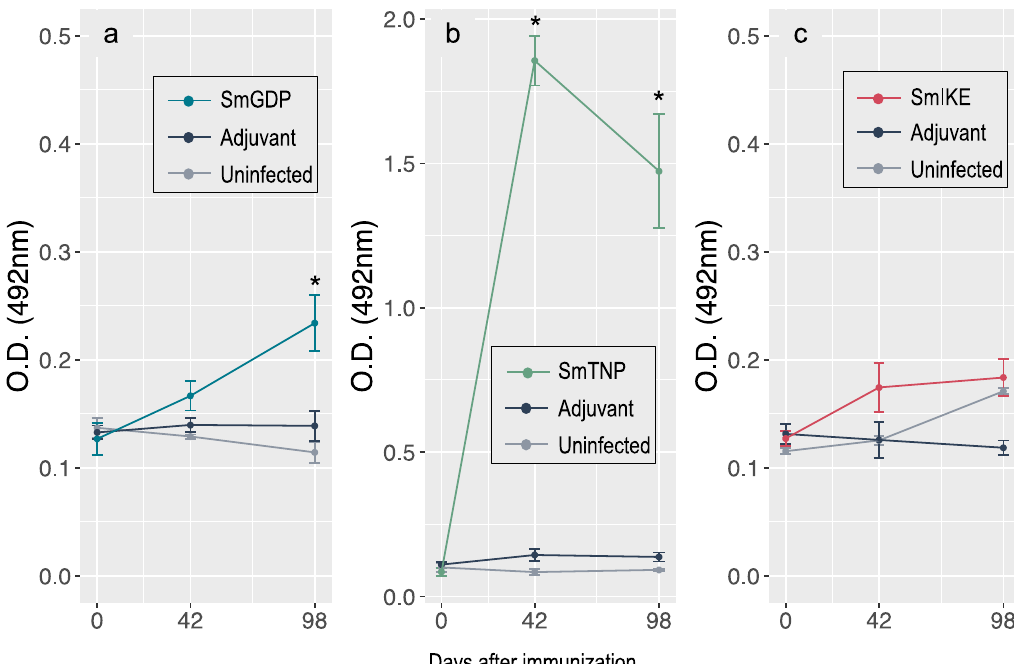
Figure 2. Specific IgG levels (means ± SEM) by indirect ELISA elicited by ( a ) SmGSP peptide, ( b ) SmTNP peptide and ( c ) SmIKE peptide formulated in the adjuvant adaptation (ADAD) vaccination system, with AA0029 and Quillaja saponaria saponins, 0, 42 and 98 days after the first immunization in BALB/c mice. * Statistically significant differences compared to the uninfected group ( p < 0.05).